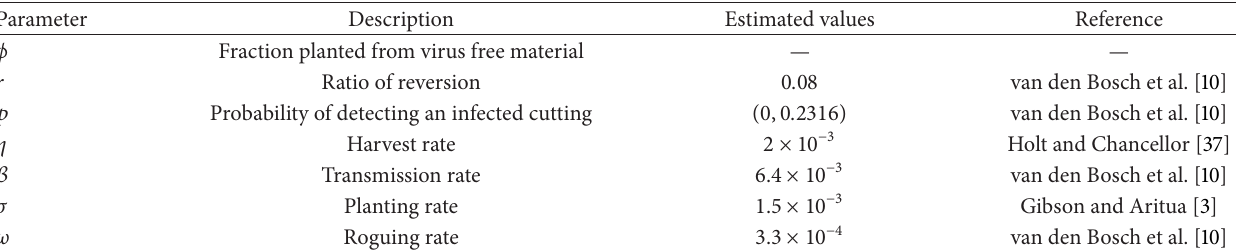
Table 1: Description of variables and parameters in model (6).